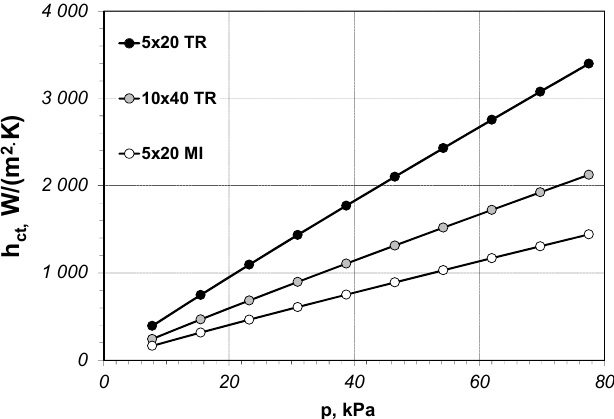
Figure 10. The changes of contact conductance for selected samples in the function of contact pressure.